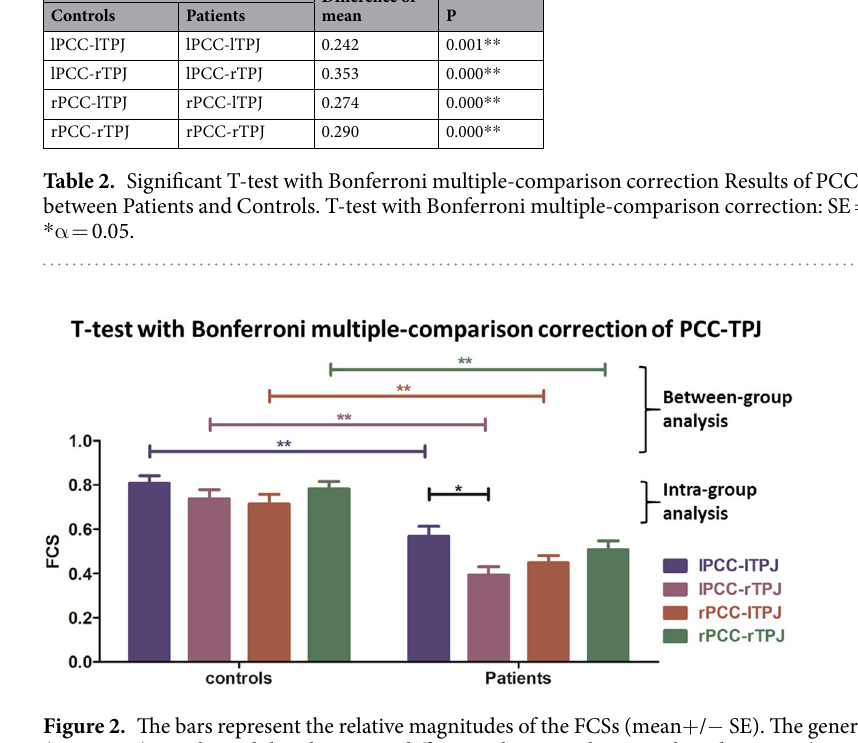
patients according to the GCS scores: high-scoring (GCS = 12–15) patients (n = 11) were compared with a sub- group of medium- (GCS = 9–11) and low- (GCS = 3–8) scoring patients (n = 9). This result revealed significantly lower PCC-TPJ FCSs in the medium/low group than in the high group. A highly significant difference was found for the cross-hemispheric PCC-TPJ FCS between the two subgroups, whereas a significant difference was not detected in the intra-hemispheric PCC-TPJ FCS (see Fig. 3). Second, Spearman’s correlation analyses were conducted between the PCC-TPJ resting state FCS and the GCS scores and between the PCC-TPJ resting state FCS and the CRS-R scores (See Table 3 and Fig. 4). Interestingly, only the cross-hemispheric PCC-TPJ resting state functional connectivity predicted the level of